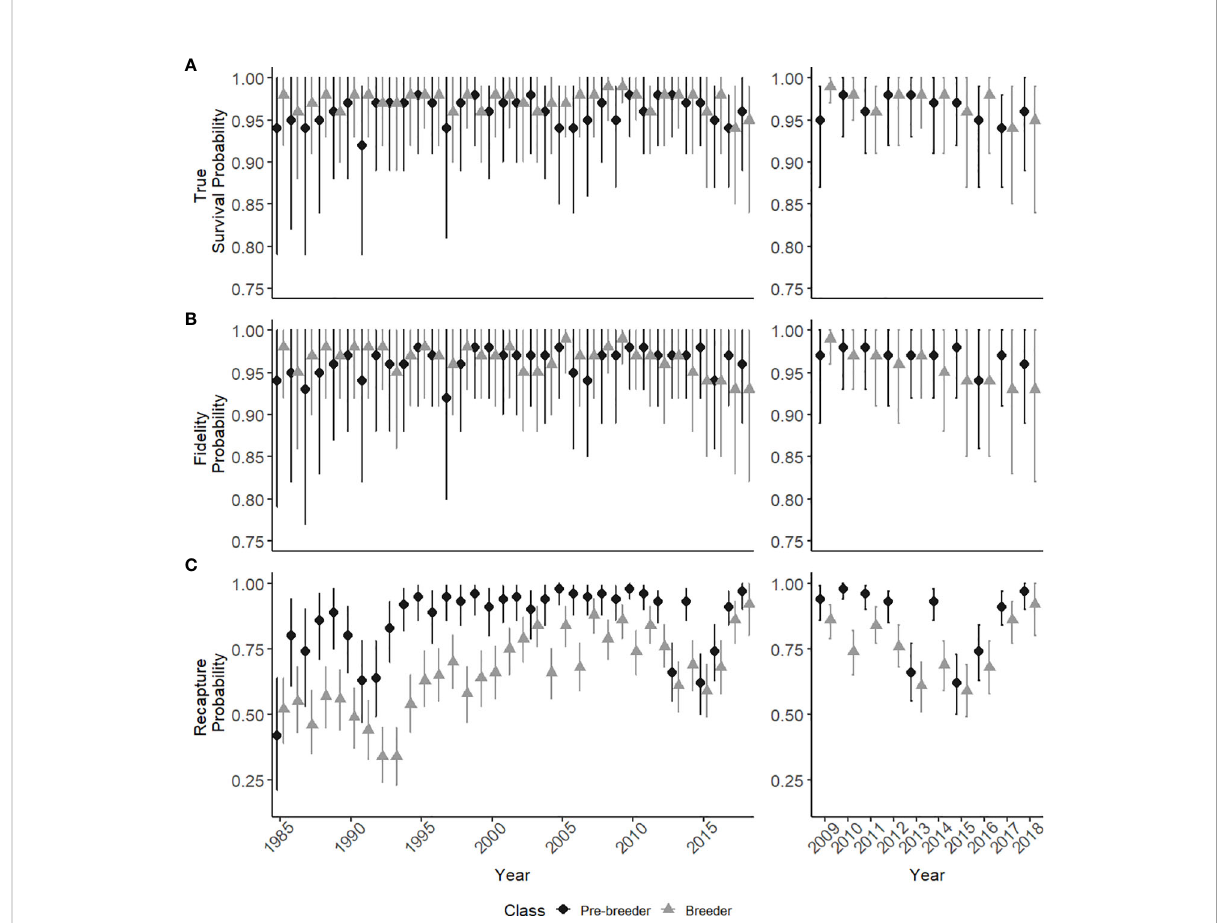
FIGURE 3 State speci fi c parameter estimates from 1985-2018 with 95% credible intervals (95% CI), for pre-breeders (dark circles) and breeders (light triangles). (A) The true survival probability (B) Fidelity probability (C) The recapture probability. Windows show a detailed view of the last ten modelled